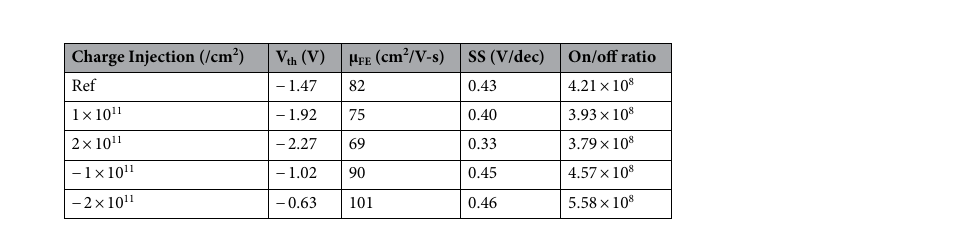
Table 2. Estimated TFT parameters with respect to charge injection from the SiO 2 /PI interface by TCAD simulation.